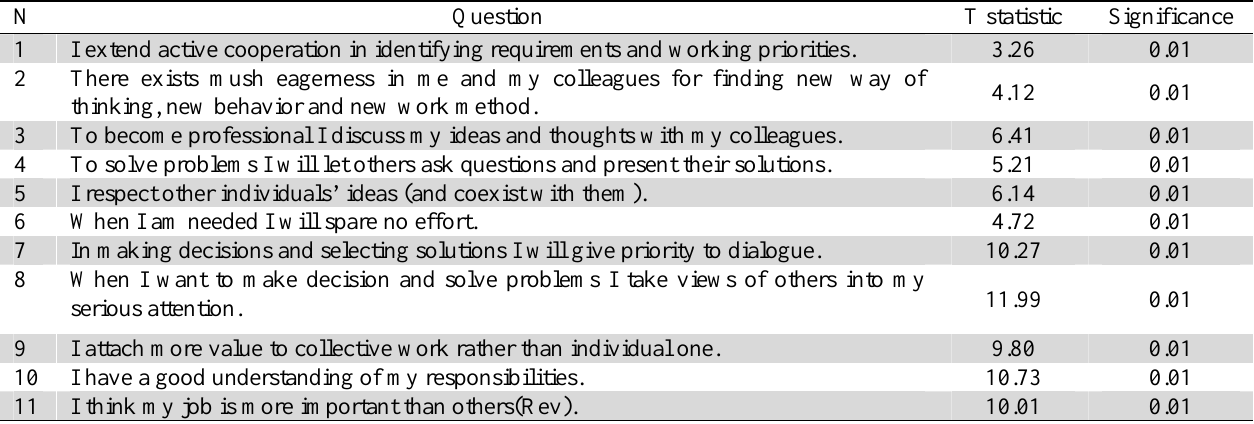
Content validity of the collaboration questionnaire